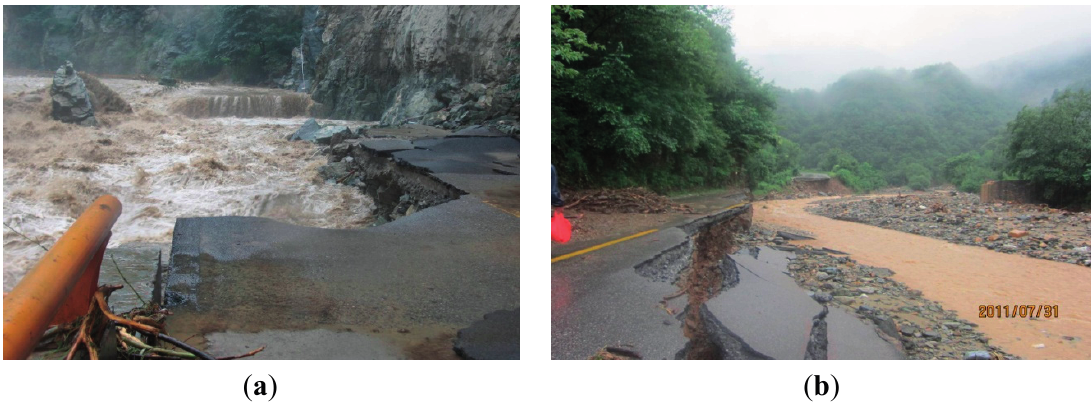
Figure 1. Flood damages to highways. ( a ) Whole-width damage; ( b ) Half-width